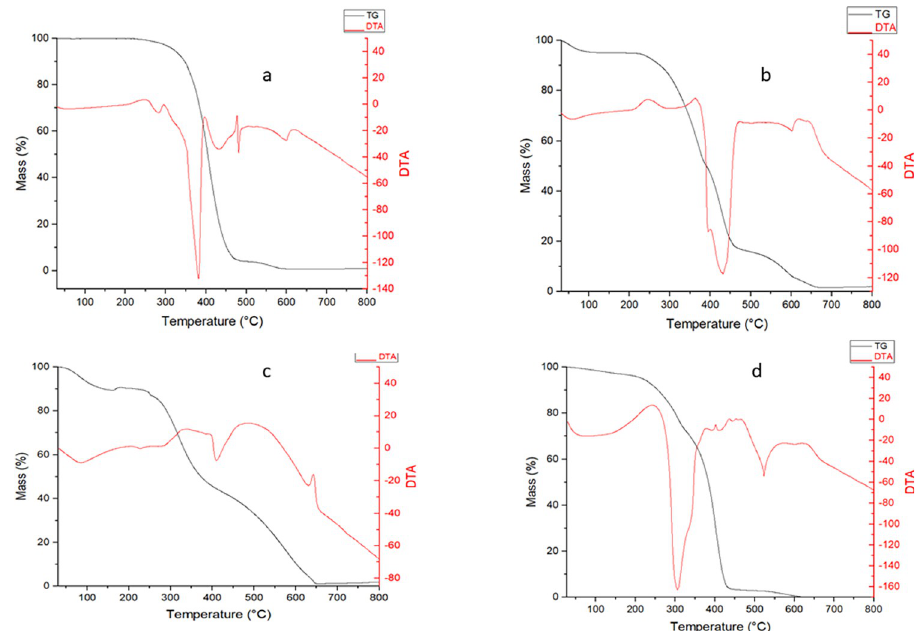
Fig 3. Thermogravimetry graphs and differential thermal analysis. a) Porcine gelatin b) Tween 20 c) Buriti oil d)